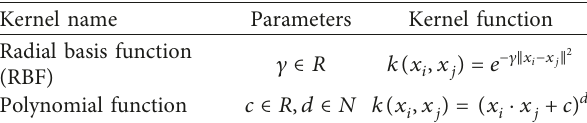
Figure 3: Nonlinear separating hyperplane for the nonseparable case of SVM. Table 1: Summarized kernel functions